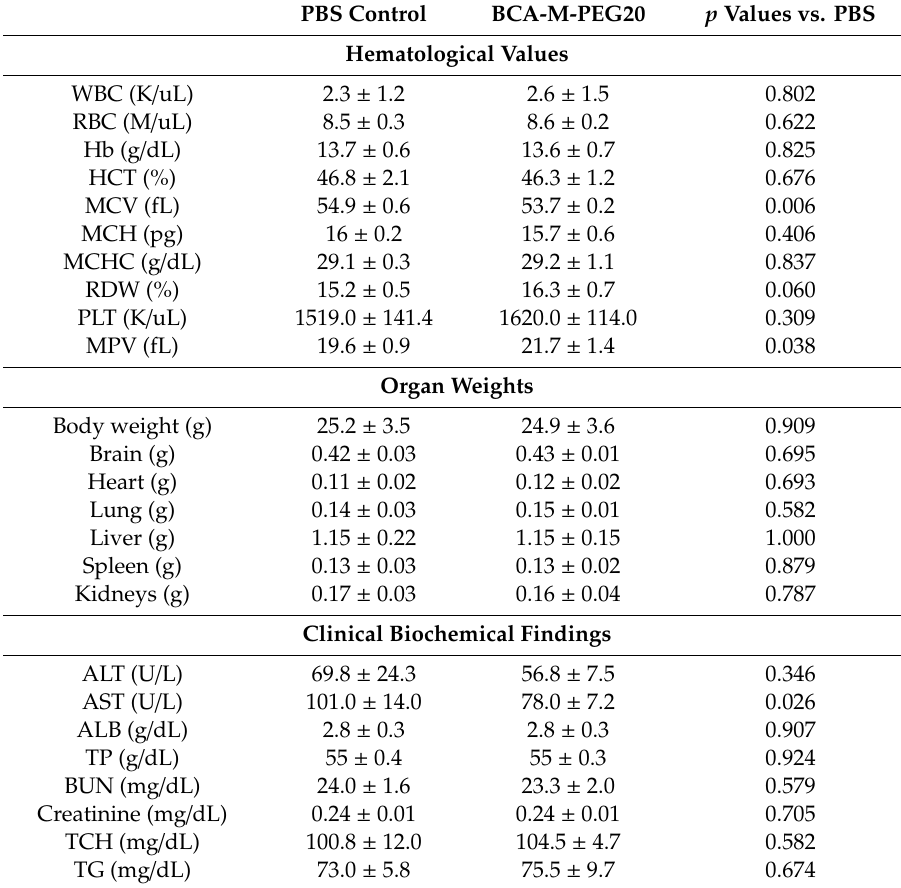
Table 4. Safety evaluation of BCA-M-PEG20 administration in mice. PBS Control p Values vs.